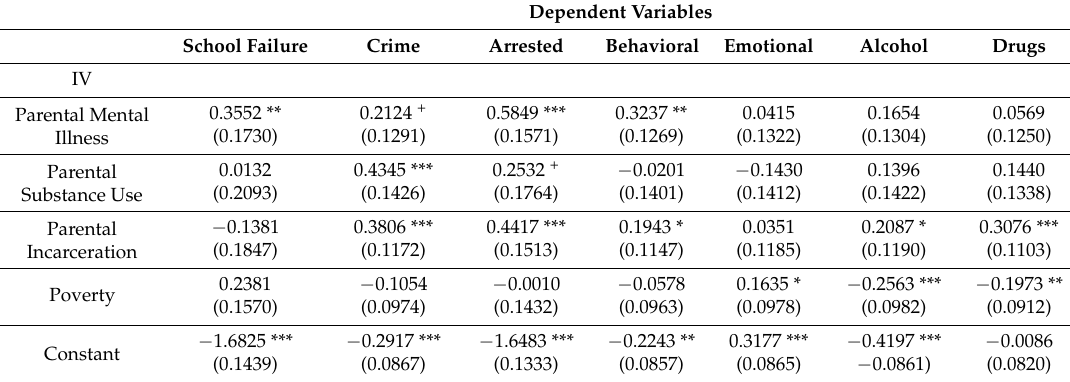
Table 4. Probit Regression